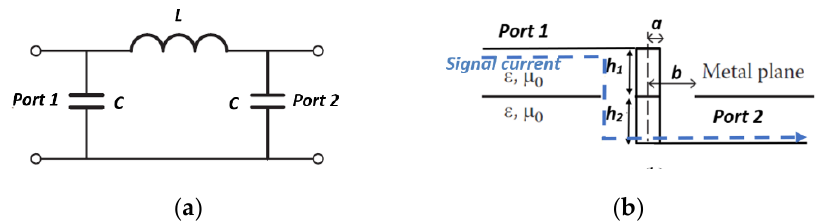
Figure 1. Via ( a ) equivalent circuit ( b ) cross section; where a represents the radius of the via-hole pin, b represents the radius of the circular slot h 1 + h 2 is the thickness of the via-hole pin. The via has parasitic capacitance, as discussed in [28,29]. The capacitance associated with the via is obtained from Gauss’s law of coaxial capacitor formula, in which the field magnitude equals the absolute value of the total charge enclosed, divided by the surface area in (3) and (4). The simplified capacitance is expressed in (5) [30]: